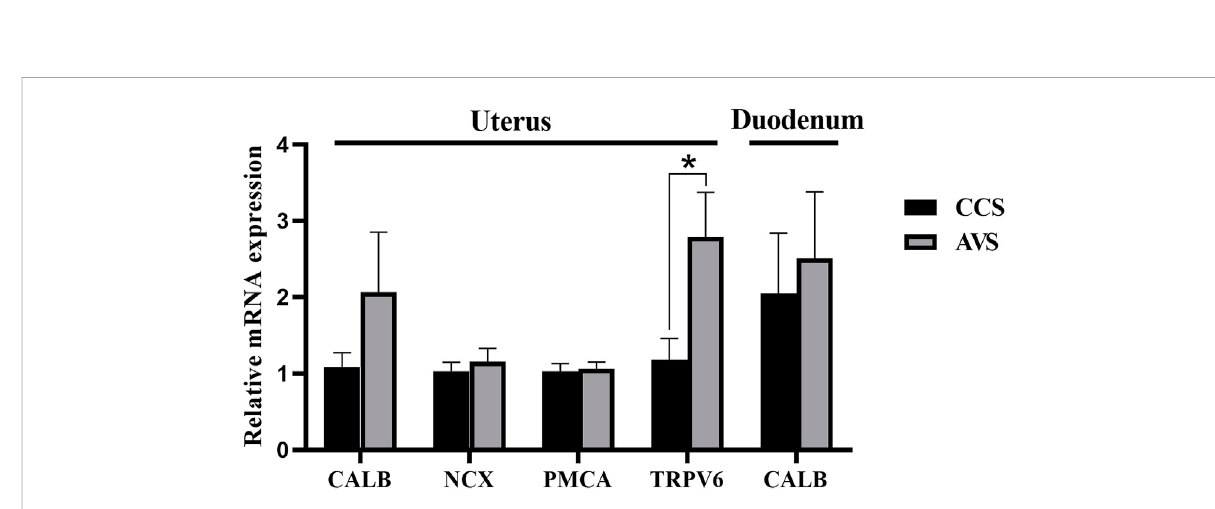
FIGURE 6 Effectofrearingsystemsonquanti fi cationofCatransport-relatedmRNAinduodenumanduterusofagedlayinghens(95weeksofage)(n=6). CCS, conventional caging system; AVS, aviary system. CALB, calbindin; NCX, Na + /Ca 2+ exchange; PMCA, Ca 2+ ATPase; TRPV6, transient receptor potential cation channel, subfamily V, member 6. Data represent means with standard error. * p <